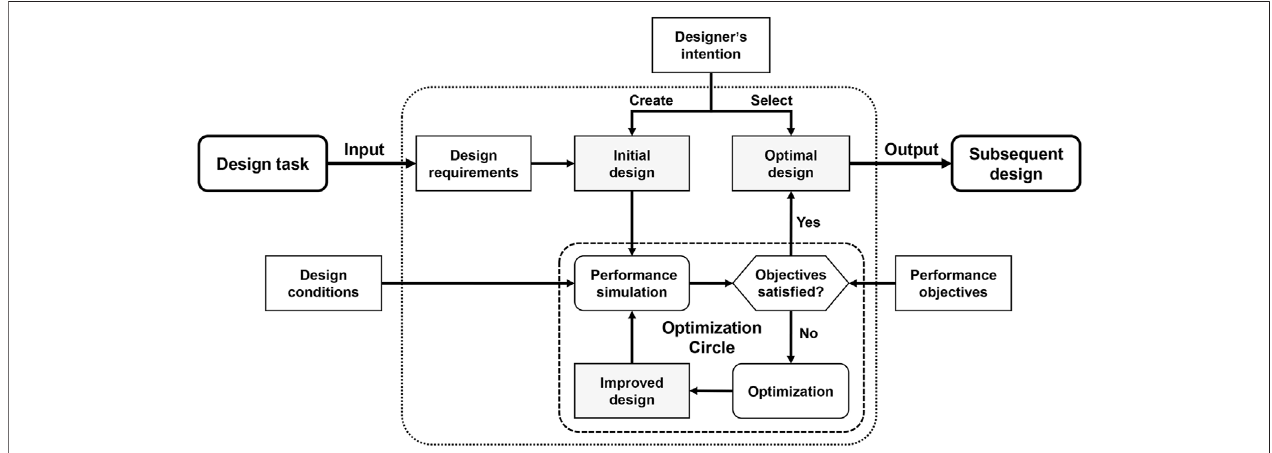
FIGURE 2 | The “ white box ” design